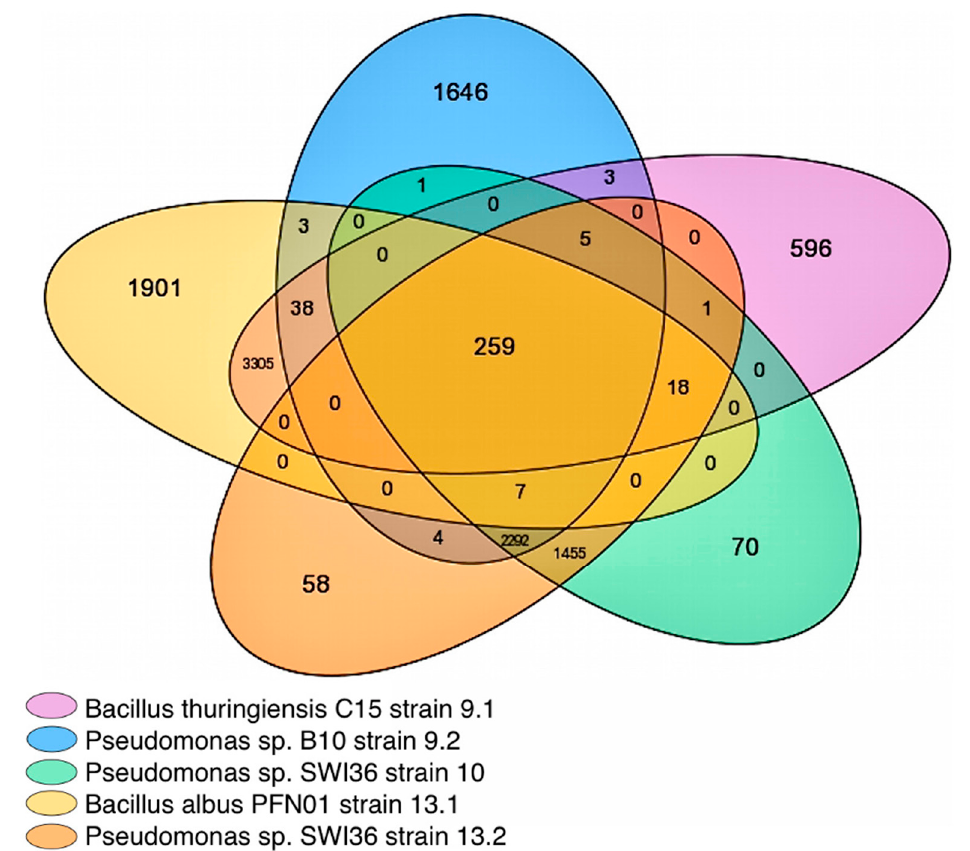
Figure 1. Venn diagram illustrating the number of genes within the pangenome of all five bacterial strains. Pangenome gene clusters were analyzed using MicroScope gene families (MICFAM), com- puted with the SiLiX softwares [38]. Genes were considered orthologs if genes contained >50% amino acid sequence similarity and 80% alignment coverage. Diagram generated by MicroScope platform with Creative Commons Attribution 4.0 International License, public use.